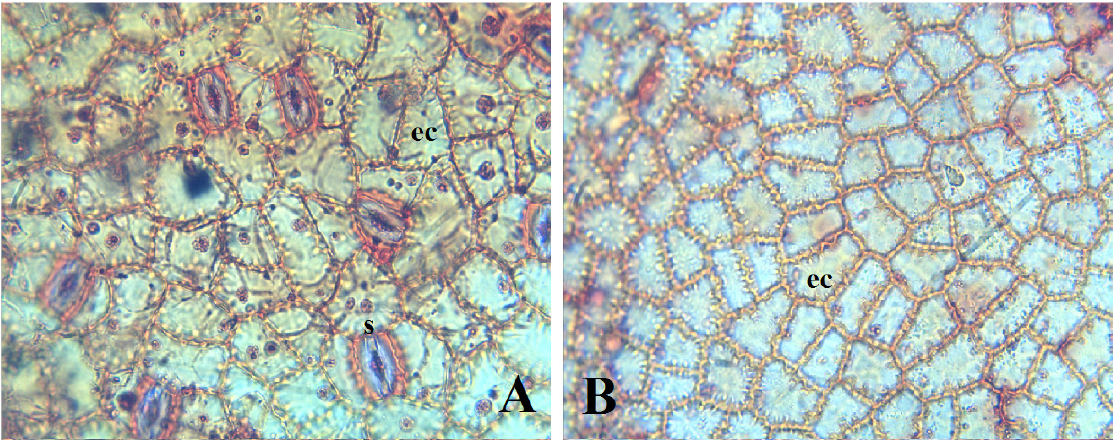
Plate 1. Photomicrographs of the foliar epidermal layers of D. tripetala. X400. A: abaxial surface; B: adaxial surface. ec-